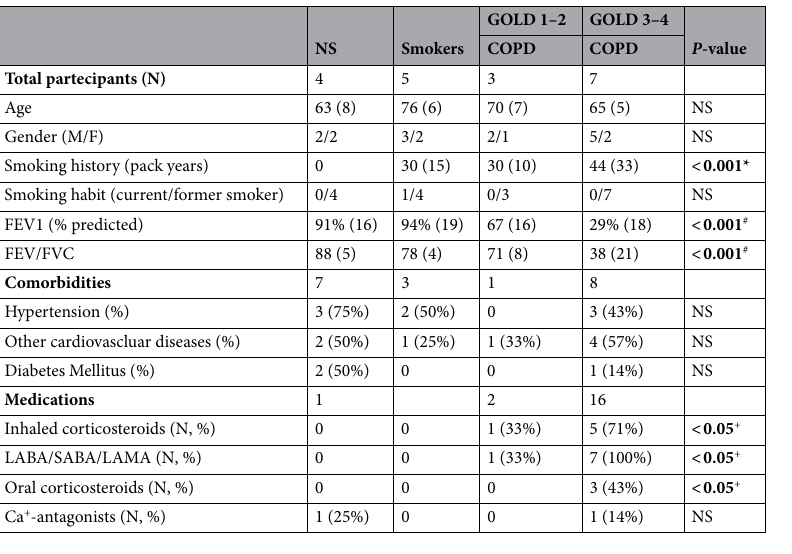
Table 1. Demographic characteristics thoracic surgery cohort (n = 19). Data are mean ± SD, unless specified. NS = Never-smokers; COPD: chronic obstructive pulmonary disease; GOLD: global initiative for chronic lung diseases. LABA: Long-acting beta-agonists; SABA: short-acting beta-agonists; LAMA: long-acting muscarinic agents; ACEi: ACE-inhibitors; ARB: angiotensin receptor blockers. * p value = smokers, GOLD 1–2 COPD, and GOLD 3–4 COPD versus NS. # p value = GOLD 3–4 COPD versus all the groups, and GOLD 1–2 versus NS,